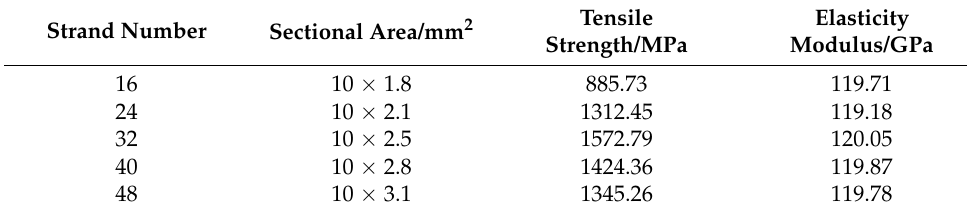
Table 2. Properties of CFRP